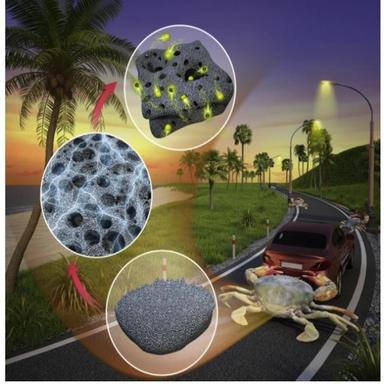
The evolution from crab waste to CDC and its applications in supercapacitors.